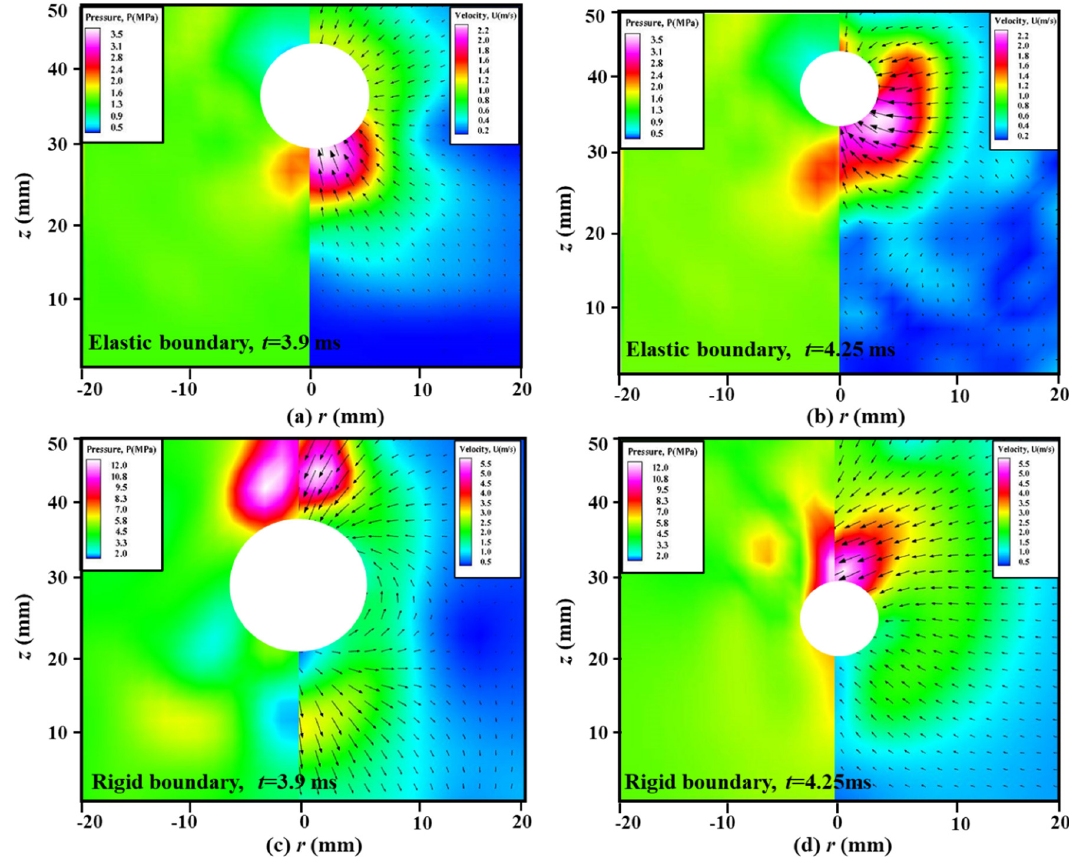
Figure 14. The measured velocity fields (right) and calculated pressure contours (left) around a shrinking bubble: ( a ) and ( b ) near the elastic boundary for time t = 3.9 ms and 4.25 ms; ( c ) and ( d ) near the rigid boundary for time t = 3.9 ms and 4.25 ms. The high-pressure region is caused by the Bjerknes force, buoyancy and vibration force for elastic boundary, while it is only caused by Bjerknes force and buoyancy for rigid boundary.